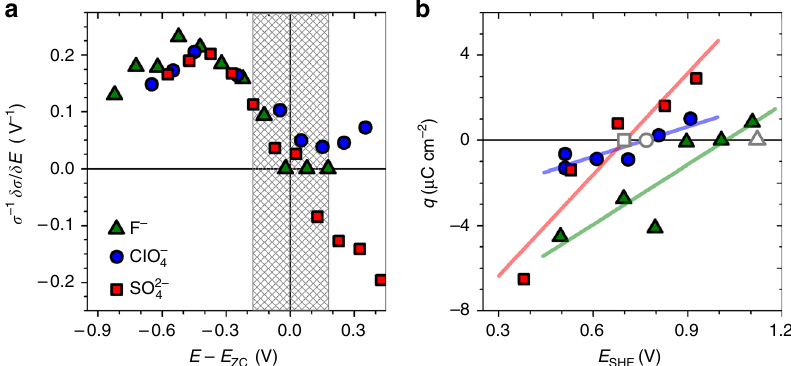
Fig. 6 Experiments with different anions. a Normalized fl ow-stress electrode-potential coupling parameter σ − 1 δ / δ E , plotted vs. difference, E − E zc , between electrode potential and the potential of zero charge, E zc . Note the excellent agreement in the capacitive regime. b Immersion charge density, q , vs. electrode potential. Intersects of linear fi ts with the abscissa provide E zc . Open symbols: E zc from separate experiments using open-circuit immersion, see “ Methods ” . Shaded: error range for E zc . Mean ligament diameters are 40 nm; anions are indicated in